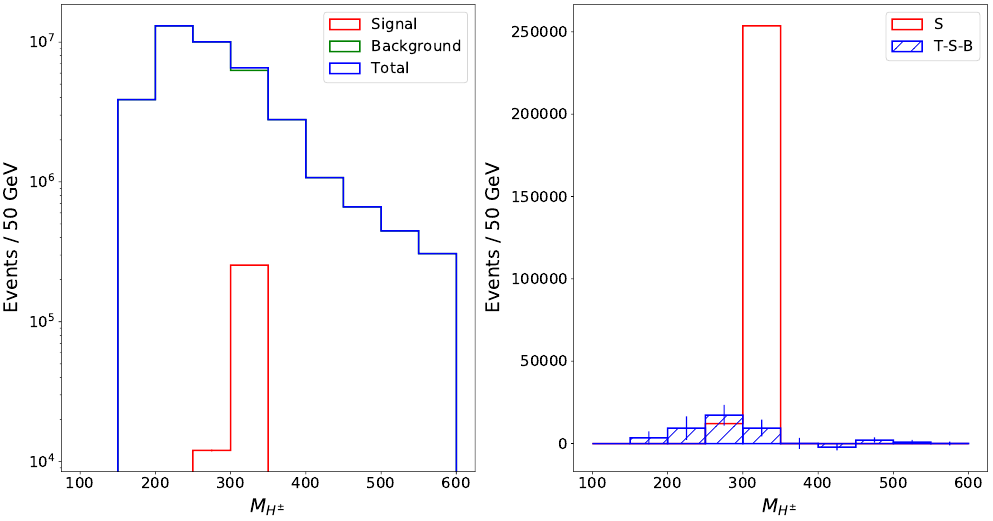
Figure 10 . The charged Higgs invariant mass distribution of the signal, background and total samples (left) and interference and signal (right) at parton level and without cuts in the m mod+